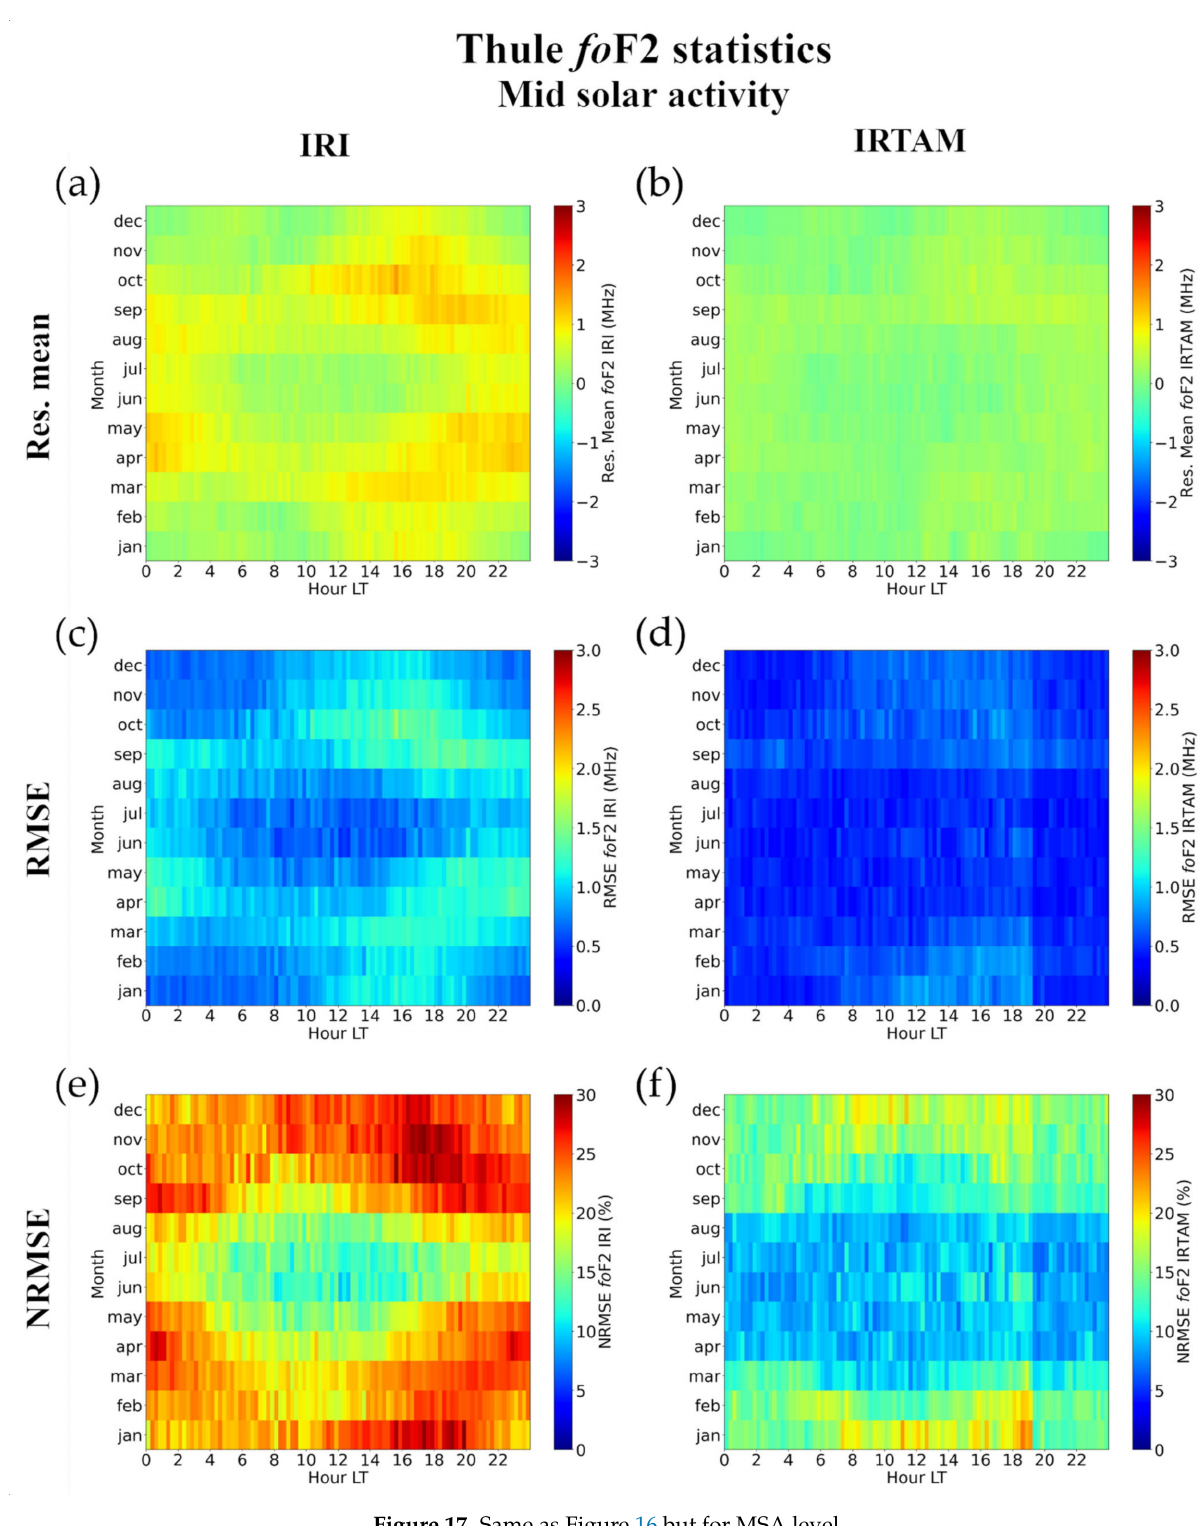
Figure 17. Same as Figure 16 but for MSA